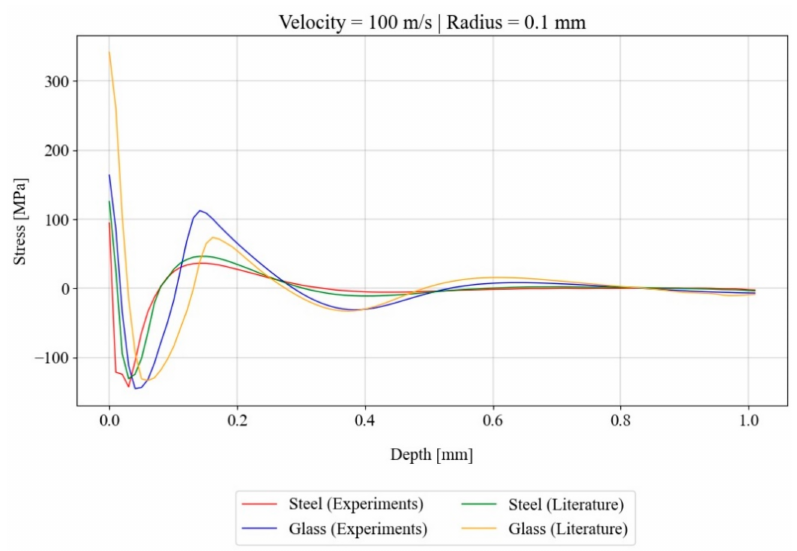
Figure 8. Resulting residual stress profiles for velocity = 60 m/s and a sphere diameter of 0.4 mm for literature and experimental